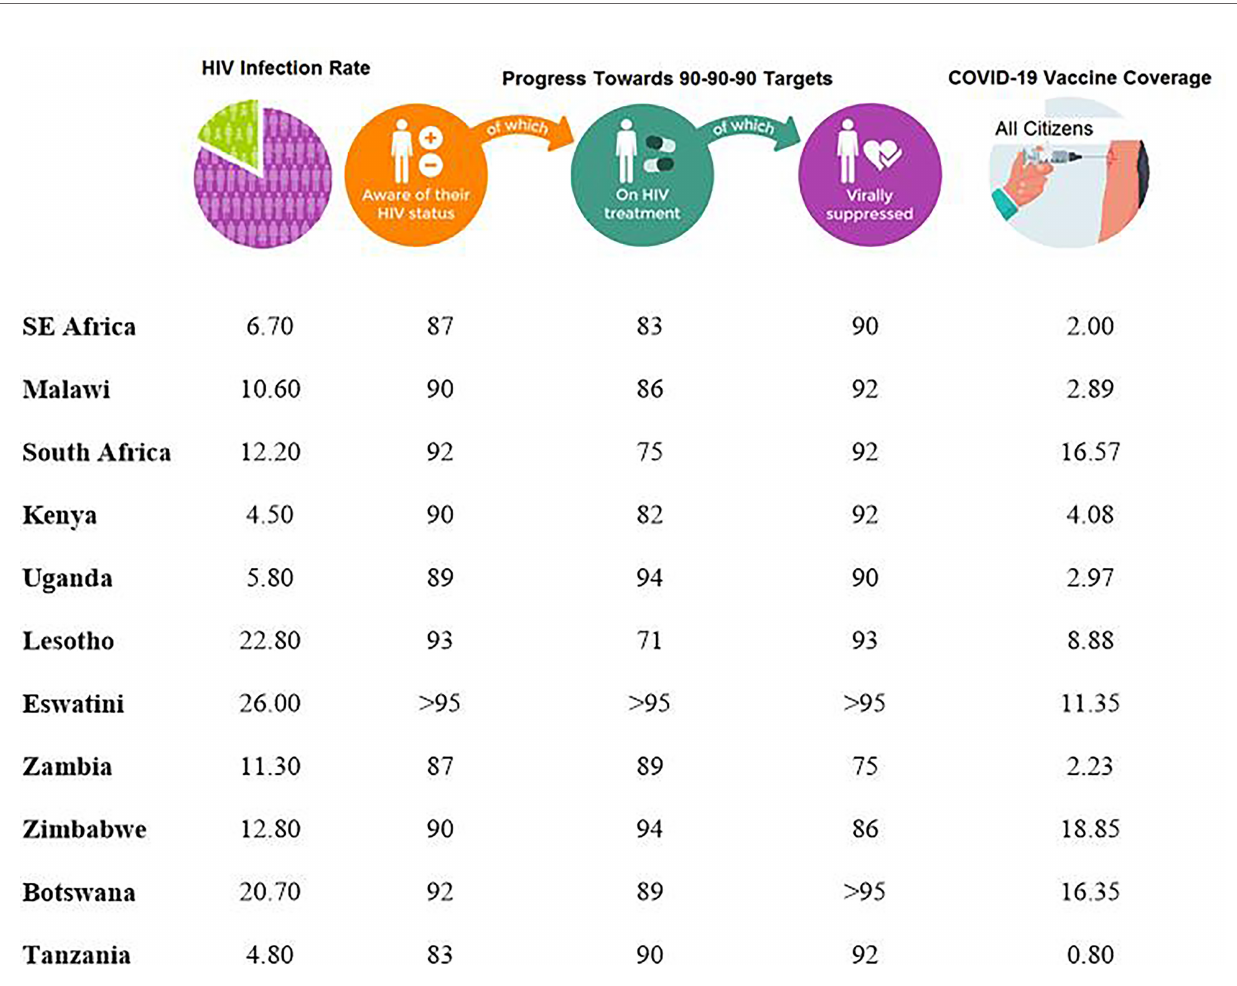
FIGURE 1 | Progress made by various countries in the Sub-Saharan Africa towards achieving the 90-90-90 Targets as of 2020 (70) and COVID-19 percentage coverage for individuals who had been fully vaccinated, regardless of HIV status, in each country as of September 2021